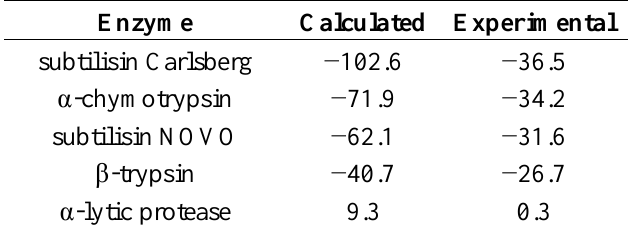
Table 1. Calculated relative electrostatic interaction energies, vs. relative experimental enzyme activities (kJ/mol) of the catalytic triad in some serine